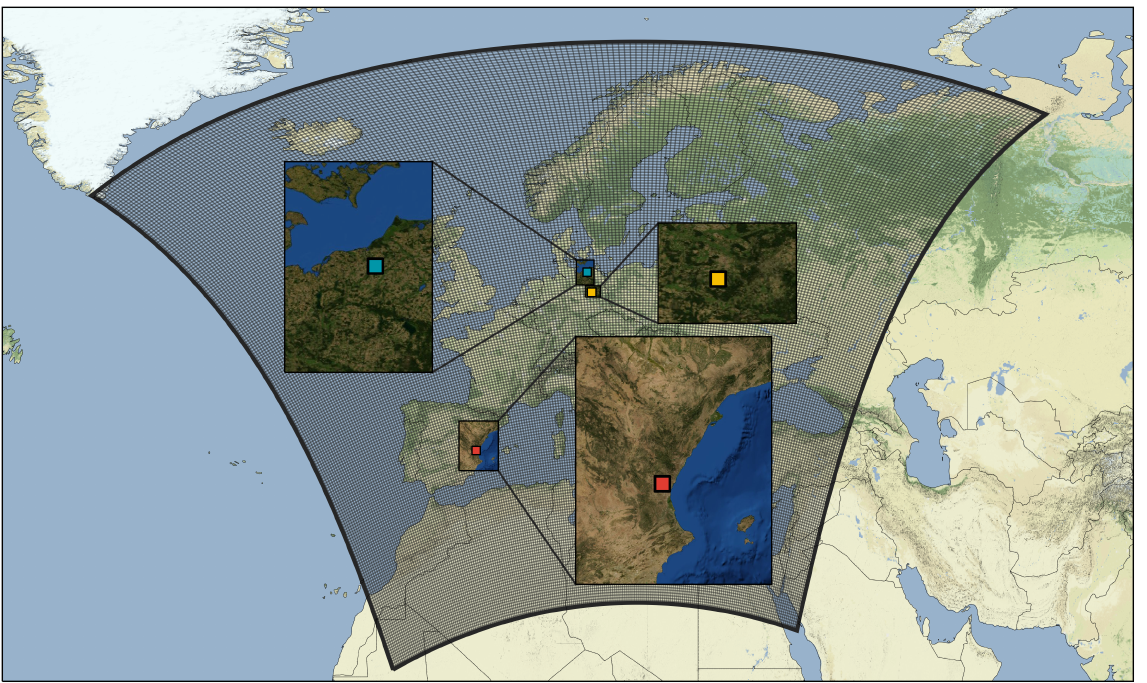
Figure 2. Map of the focus regions considered in our analysis. The surrounding lattice represents the RCM simulation domain (CORDEX- EUR11). The colored boxes mark the positions of the selected meteorological stations of each focus region. The map was created based on material from http://maps.stamen.com (last access: 4 March 2019; for the background) and https://map1c.vis.earthdata.nasa.gov/wmts-geo/ wmts.cgi (last access: 4 March 2019; BlueMarble_ShadedRelief_Bathymetry for the zoomed regions). Table 4. Best performing ANN configurations after a grid search hyperparameter optimization. We optimized the ANN for each reference barn separately. The layout configurations refer to the number of nodes in each hidden layer. The predictor and predictand abbreviations are defined by T – temperature, RH – relative humidity, W – zonal and meridional wind, P – sea level pressure, and R – global radiation. Reference barn Layout Activation Predictor Predictand Total R 2